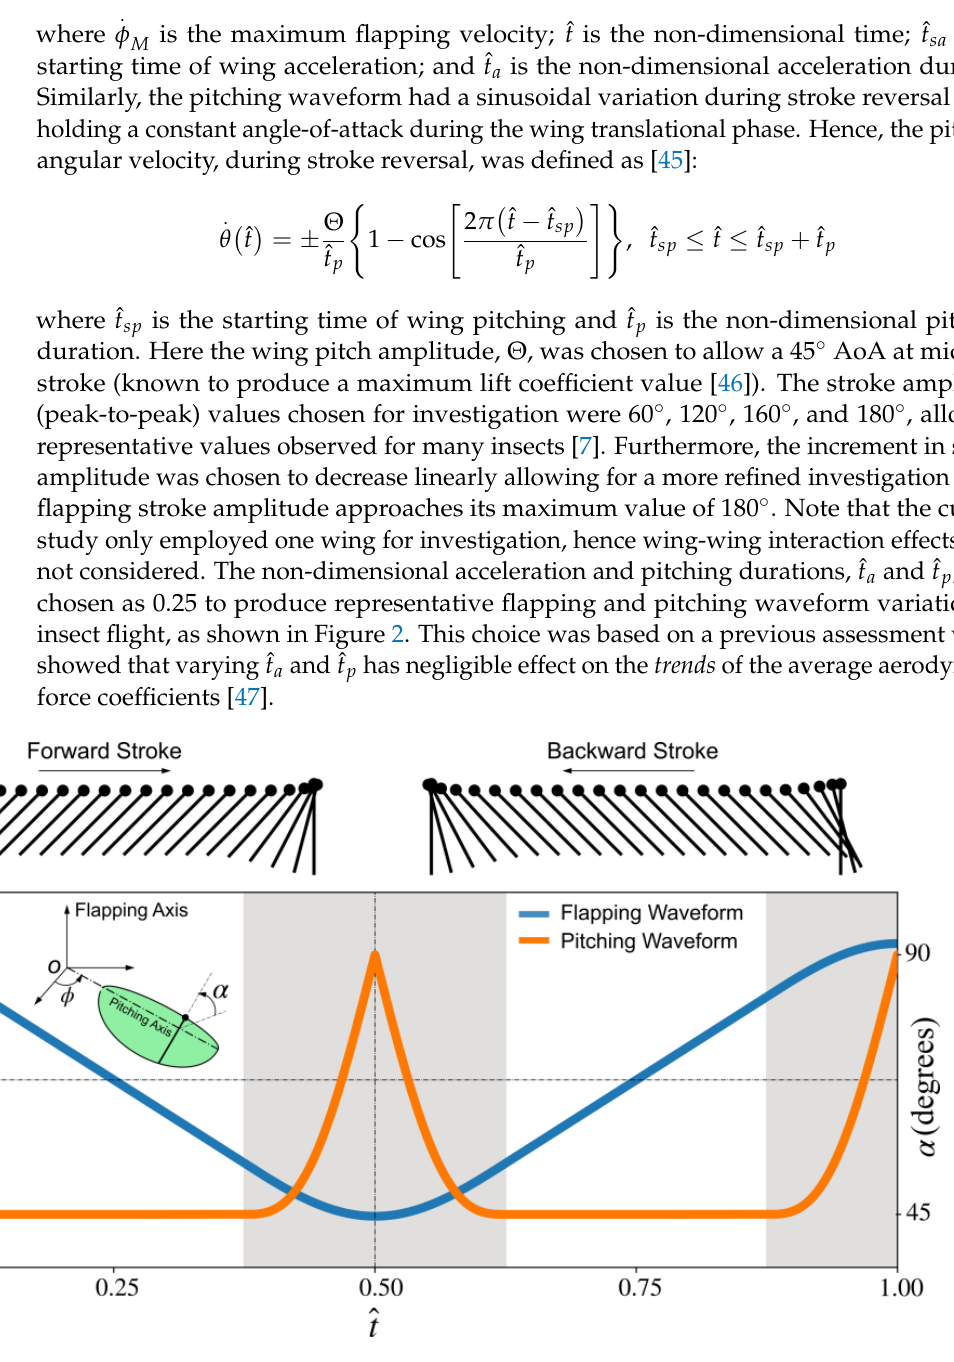
Figure 2. Flapping angle, φ , and angle of attack, α , variations employed in the current investigation. Regions with white color indicate wing translational phases, whereas regions with grey color indicate wing rotational phases.